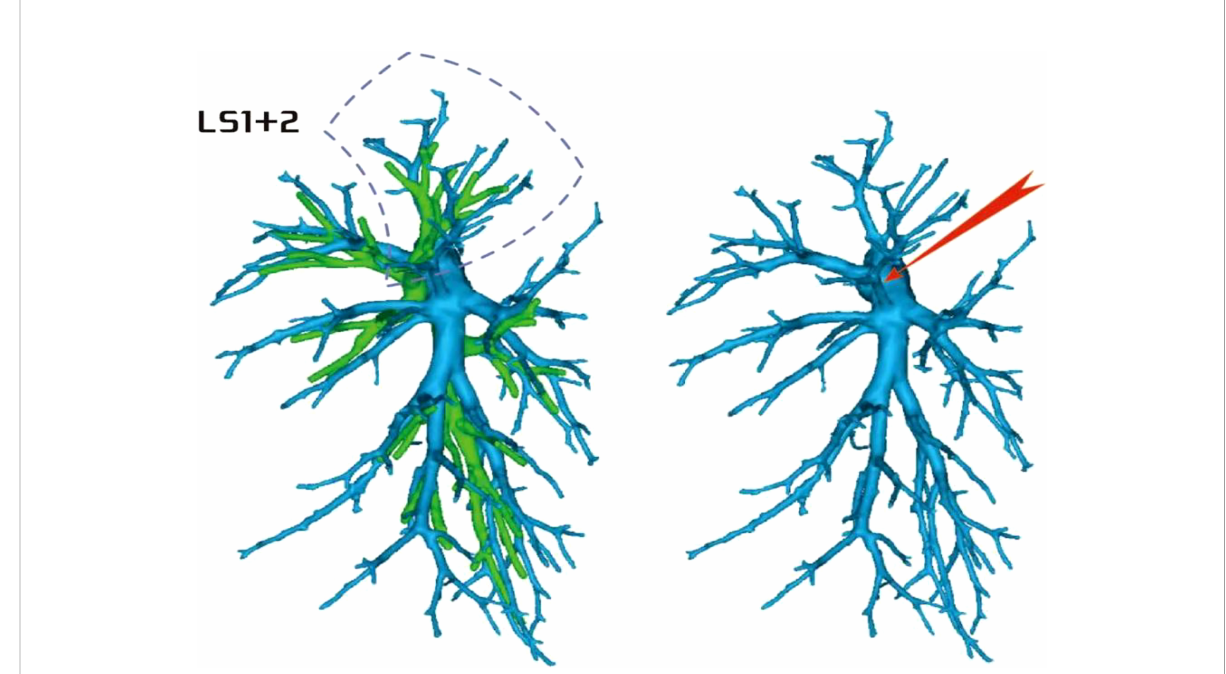
FIGURE 2 Dotted line is the LS1 + 2 area, and the red arrow indicates the branch of the lingular artery into LS1 +